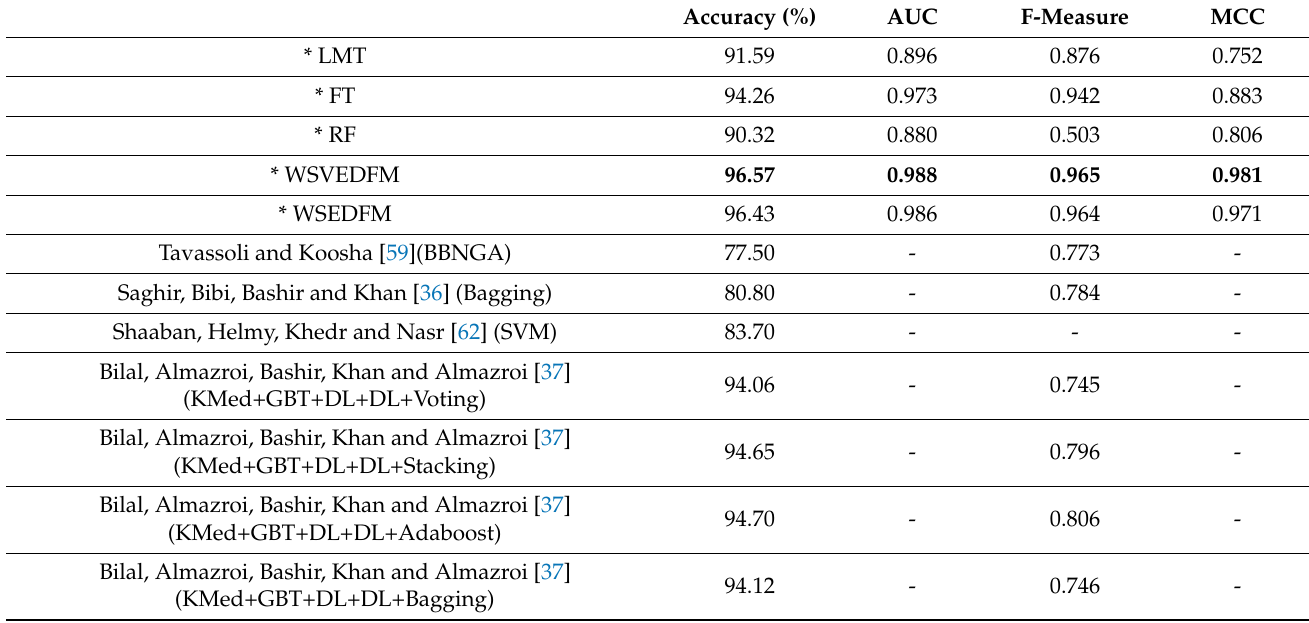
Table 16. The CCP performance of proposed DF methods and existing models on Dataset